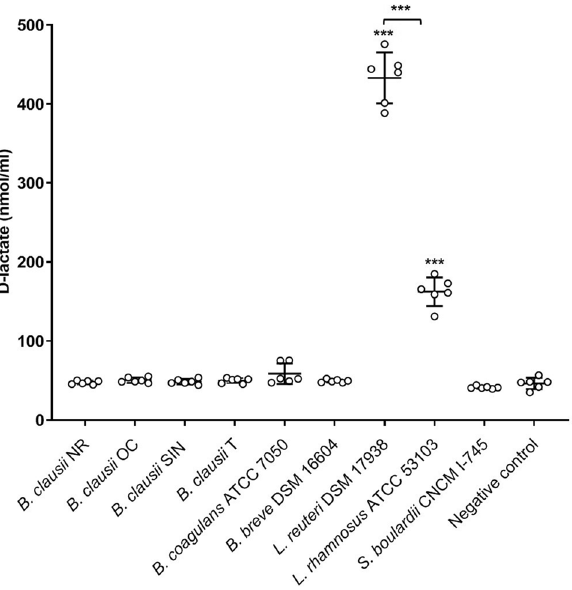
Figure 5. Production of d-lactate by probiotic microbes. Scatter plot of d-lactate concentration (nmol/ml) values determined in deproteinized culture supernatants of each microbe. Deproteinized BHIG was used as negative control in the assay (i.e. negative control). Three independent biological replicates with two technical replicates each were performed. The mean ± standard deviation was also shown. The ANOVA for independent data followed by Tukey HSD test was applied. ***P <